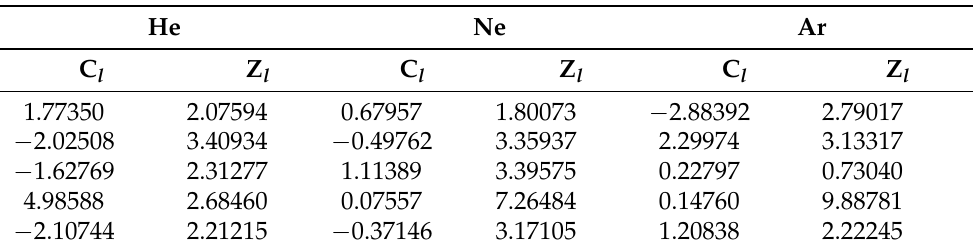
Table A1. Coefficients C l and exponents Z l for the expansion of the Ω function as described in Equation (A18) for each target